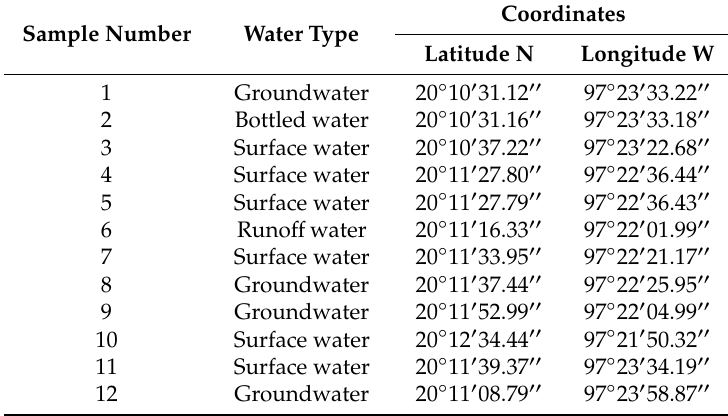
Table 1. Coordinates and type of water collected at the di ff erent sampling